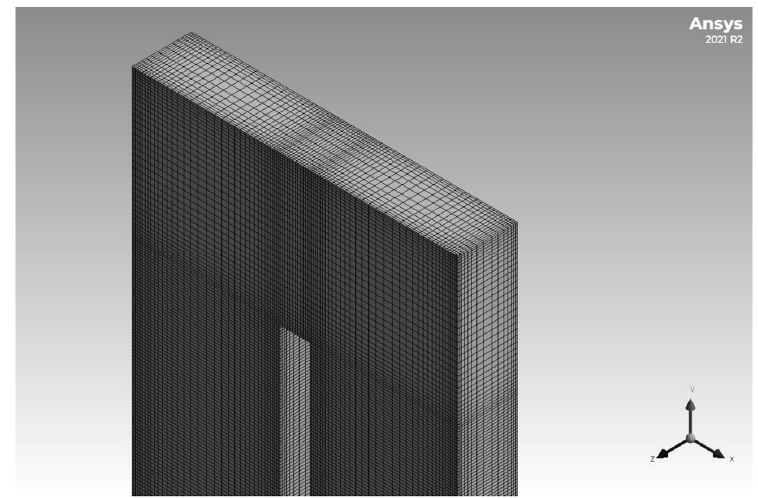
Figure 3. A 3D hexahedral mesh using ANSYS meshing. Four sets of meshes were generated, and the relative deviations of the TPLC decreased as the number of nodes increased (Figure 4), so the second set of 1,597,866 nodes was chosen for efficient computation and to maintain a certain level of reliability.